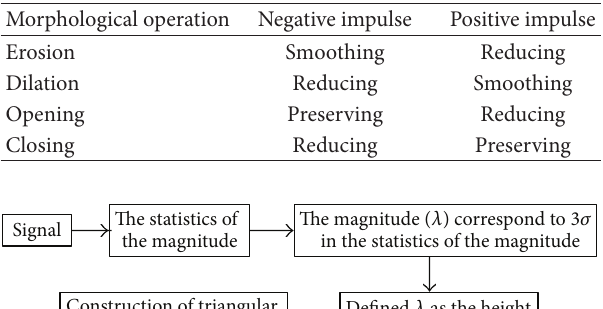
Table 1: Properties of MM operations to impulse features.